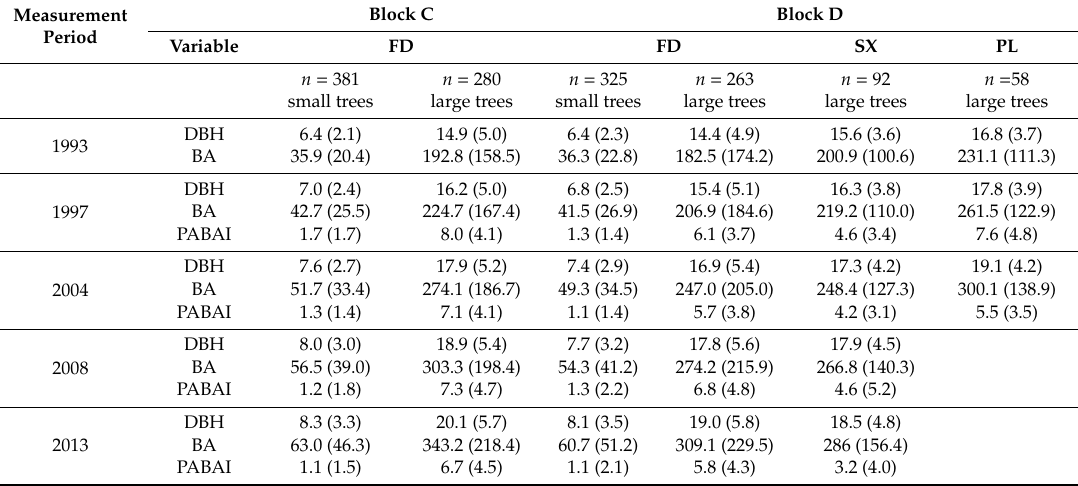
Table 3. Means and standard deviations (in brackets) for surviving trees from 1993 to 2013 by tree size and species. DBH is the diameter at breast height (cm); BA is the tree basal area (cm 2 ); PABAI is the periodic annual basal area increment (cm 2 yr − 1 ); n is the number of trees; FD is interior Douglas-fir; SX is interior spruce; and PL is lodgepole pine. Small trees were between 2.0 and 9.9 cm at the time of the 1993 measurement and large trees were ≥ 10.0 cm DBH at the 1993